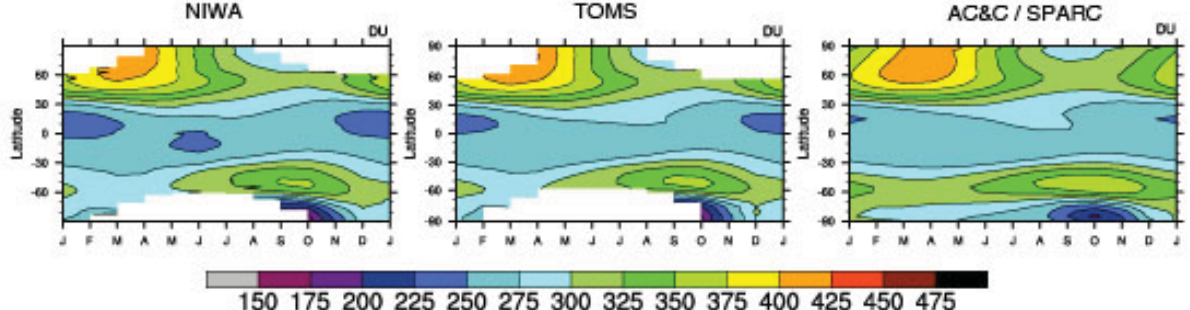
Fig. 5. Total column ozone climatologies (1980 to 1999) for the AC&C/SPARC ozone database compared to the NIWA combined total column ozone database (Bodeker et al., 2005) and TOMS (Stolarski and Frith, 2006).